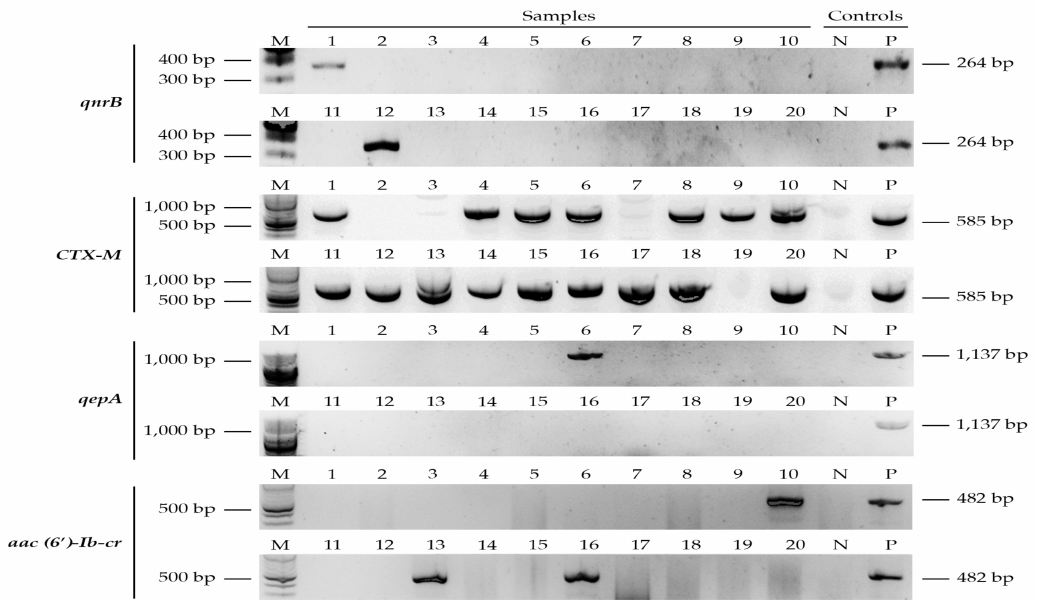
Figure 2. Gel electrophoretic bands of ESBL and quinolone-resistant genotypes ( qnrB , CTX-M, qepA , and aac ( 6 )- lb - cr ). Letters: M—DNA ladder, N—negative control, and P—positive control. Positive samples are numbers 1, 10, 12, 13, and 16 ( qnrB , aac ( 6 )- lb - cr , and qepA ) and samples 1, 4, 5, 6, 8, 9, 10, 11, 12, 13, 14, 15, 16, 17, 18, and 20